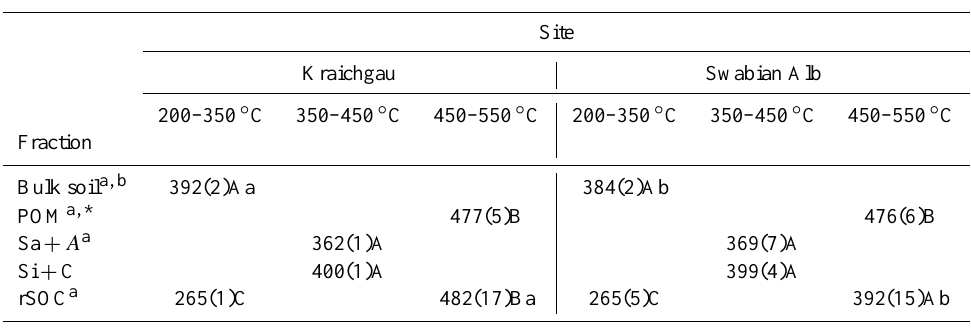
Table 4. Mean values ( ± standard error) for soil (Kraichgau and Swabian Alb) at the temperatures ( ◦ C) of peaks or “shoulders” of thermally evolved CO 2 of bulk soil and SOM fractions as measured by FTIR-EGA. Lowercase letters indicate significant differences ( P < 0.05) between peak temperatures in a row (among the sites), uppercase letters indicate significant differences ( P < 0.05) within a site among fractions.